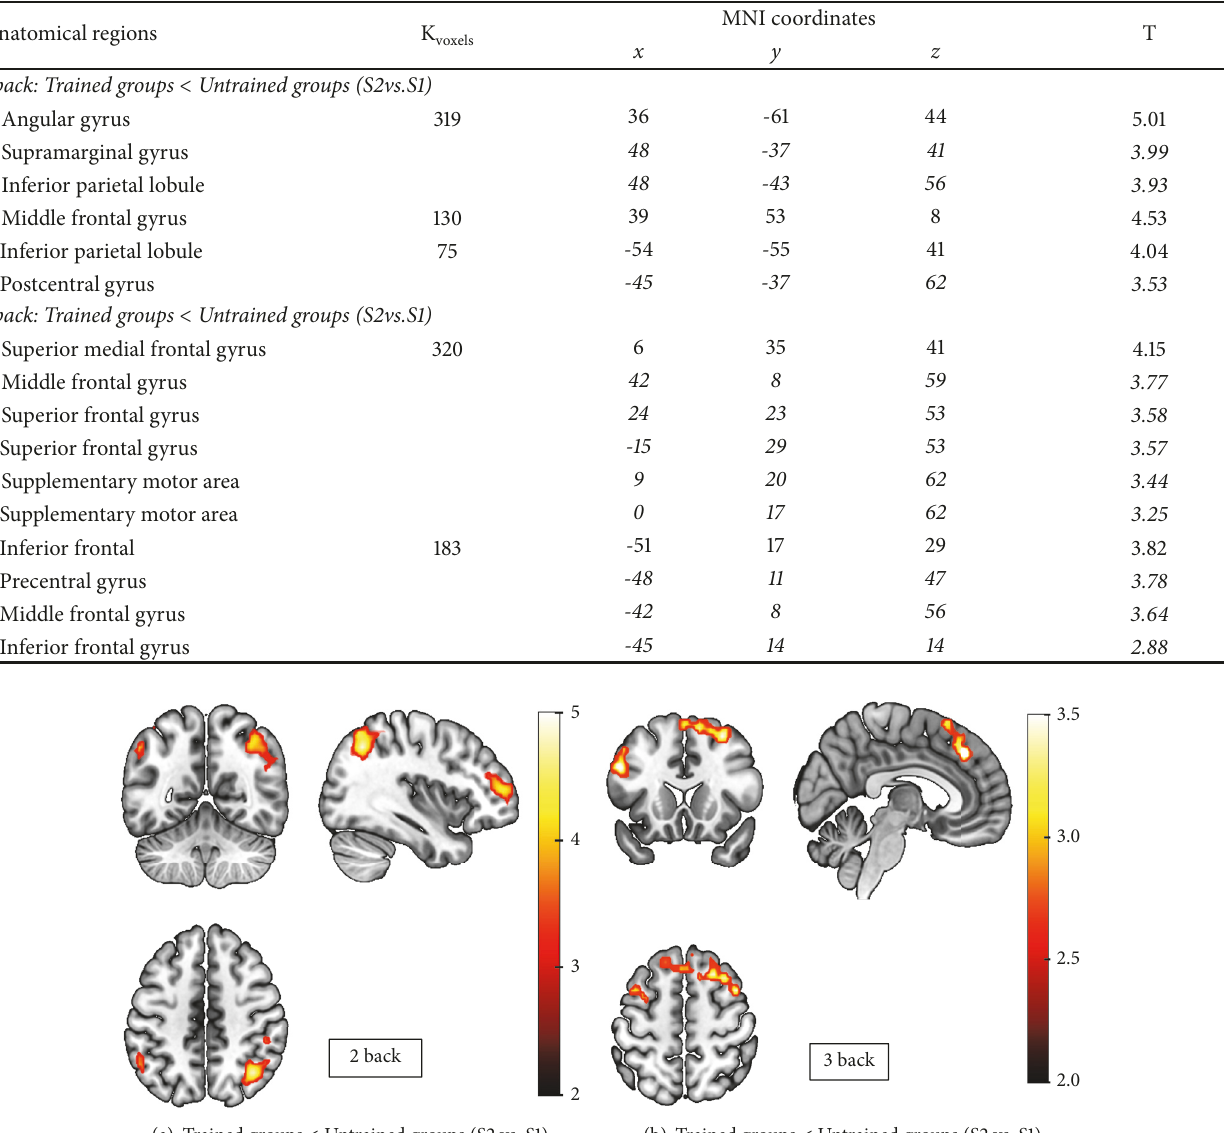
Table 2: List of brain activations as a result of the posttraining session (S2) in 2-back and 3-back load level between groups comparisons. Results were p < 0.05 FWEc cluster-corrected using a threshold of p < 0.001 at the uncorrected level and a cluster extension of k= voxels,